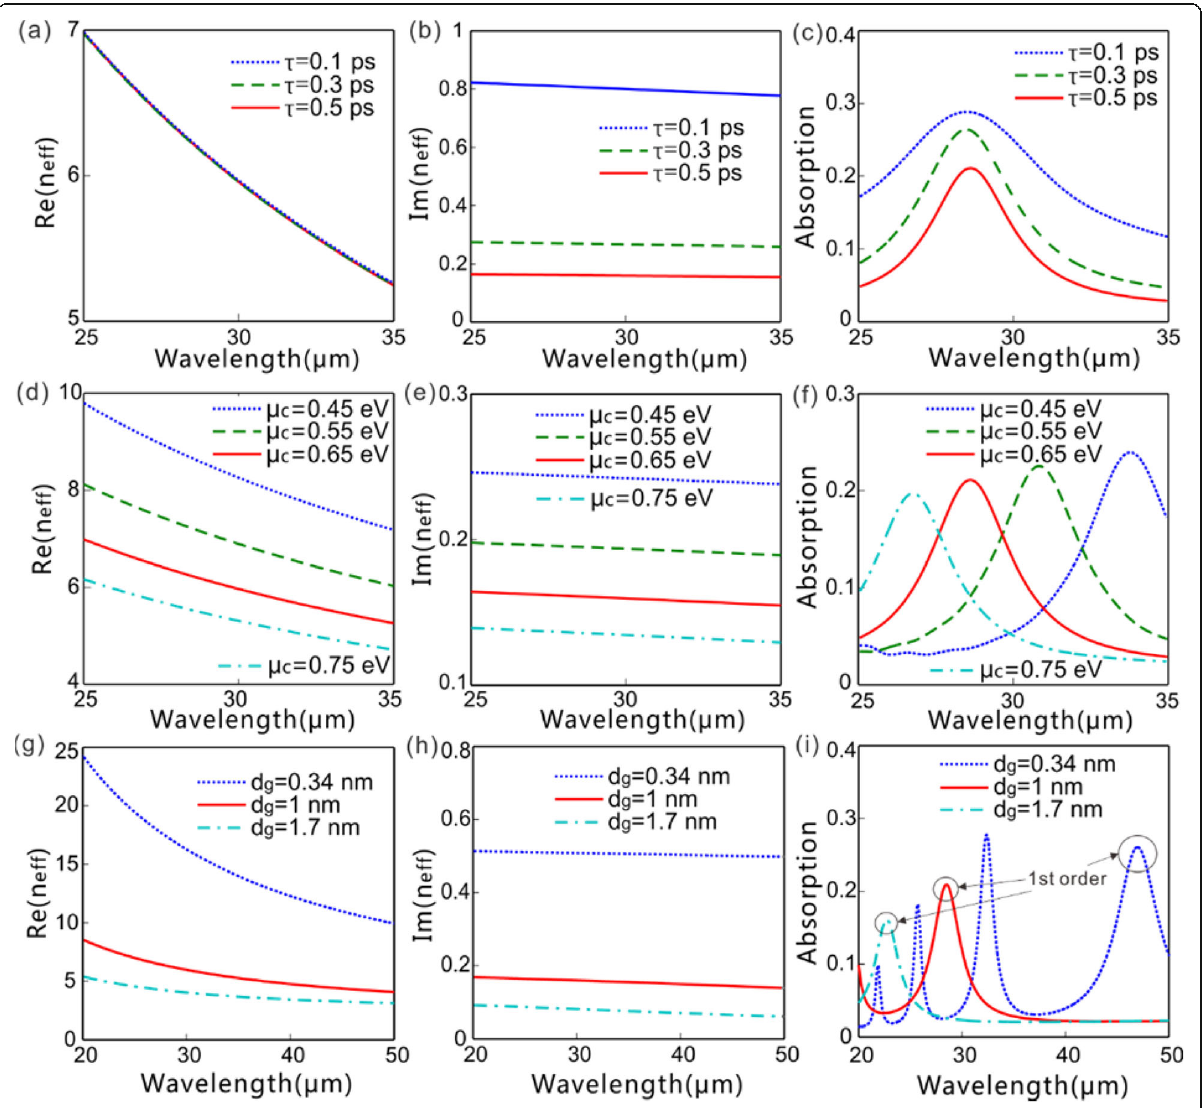
Fig. 2 The real [Re( n eff )] and imaginary [Im( n eff )] parts of the effective index, and absorption versus wavelength with different values of μ c , τ , and d g . a – c Re( n eff ), Im( n eff ), and absorption versus wavelength ( τ =0.1, 0.3, and 0.5 ps, associated with μ =0.14, 0.42, 0.69 m 2 V − 1 s − 1 , respectively) with μ c =0.65 eV and d g = 1 nm. d – f Re( n eff ), Im( n eff ), and absorption versus wavelength ( μ c =0.45, 0.55, 0.65, and 0.75 eV) with τ =0.5 ps and d g =1 nm. g – i Re( n eff ), Im( n eff ), and absorption versus wavelength [ d g =0.34 nm ( n =1), 1 nm ( n =3), and 1.7 nm ( n =5)] with μ c =0.65 eV and τ =0.5 ps. For all the cases, the grating period is fixed at p =4 μ